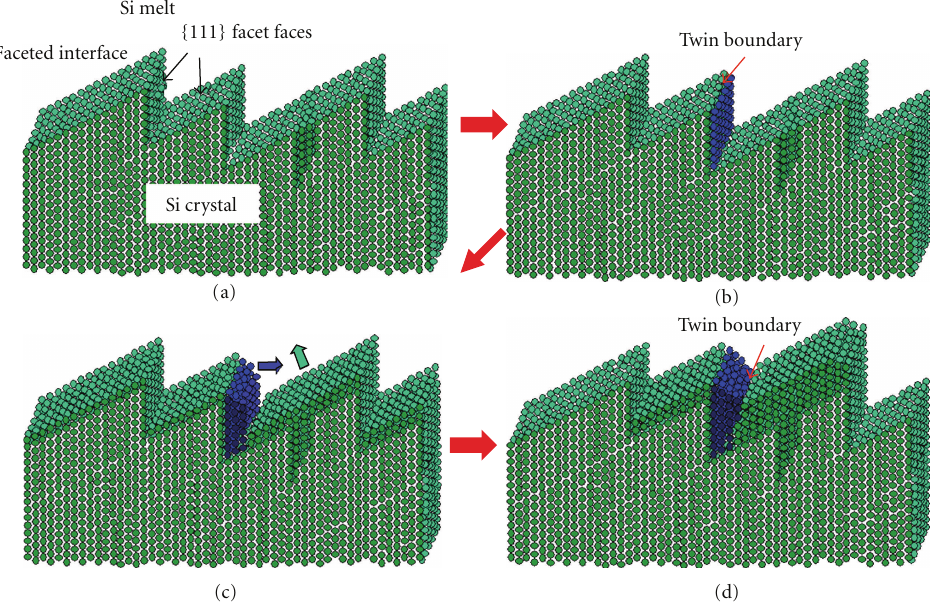
Figure 14: Model of parallel-twin formation at crystal-melt interface during crystal growth from Si melt. When a twin boundary is acciden- tally formed on a { 111 } facet plane, another twin boundary is formed parallel to the first twin after lateral growth is promoted [43].